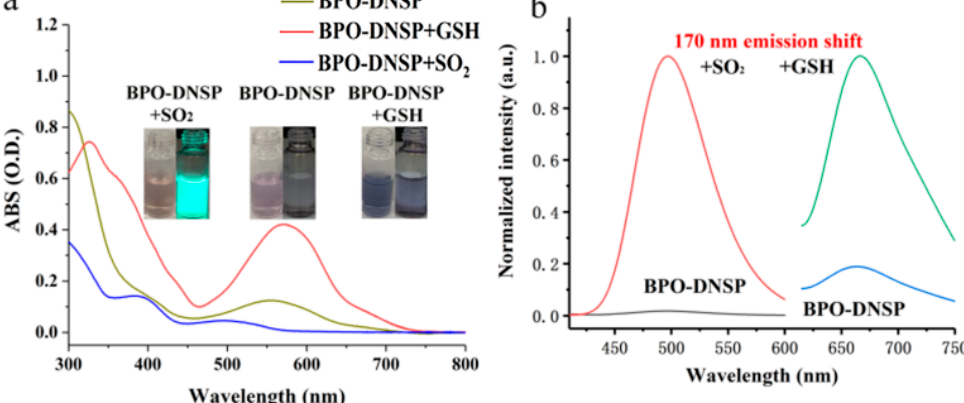
Figure 1. ( a ) UV-vis absorption and ( b ) normalized fluorescence spectra of BPO-DNSP (10 µ M) and its interaction with 500 µ M SO 2 or glutathione (GSH). Excitation wavelength for BPO-DNSP with SO 2 ( λ ex ) = 390 nm. Slit: 2.5 nm/5 nm. Excitation wavelength for BPO-DNSP with GSH ( λ ex ) = 556 nm. Slit: 10 nm/10 nm. Inset: corresponding color and fluorescence changes under visible light and a 365 nm UV lamp. λ